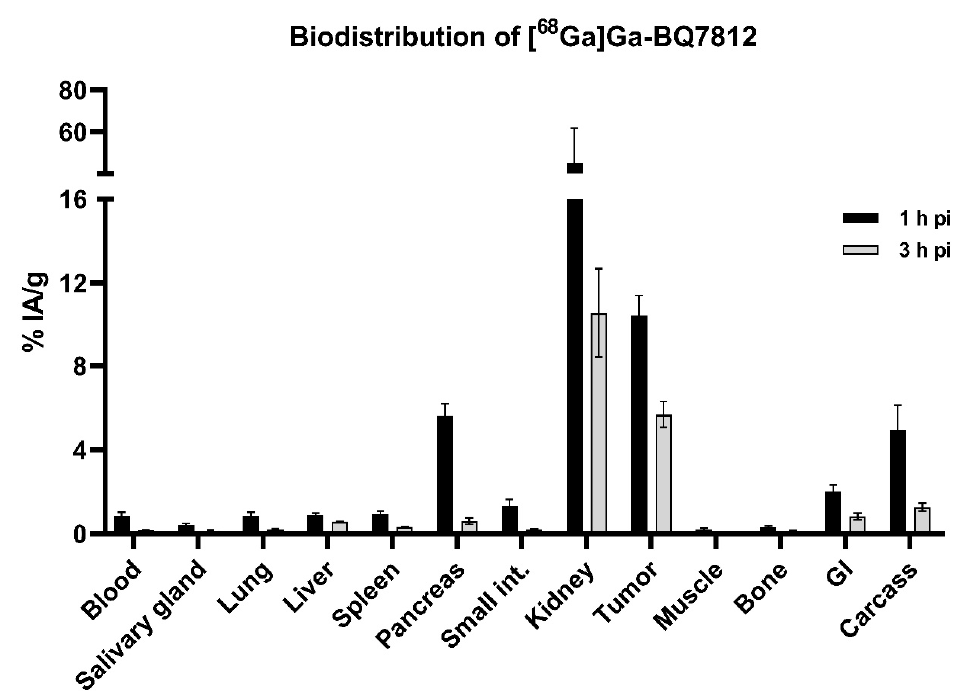
Figure 5. In vivo biodistribution of [ 68 Ga]Ga-BQ7812 in PC3-pip tumour-bearing mice at 1 and 3 h post-injection showing the uptake activity in specified organs.